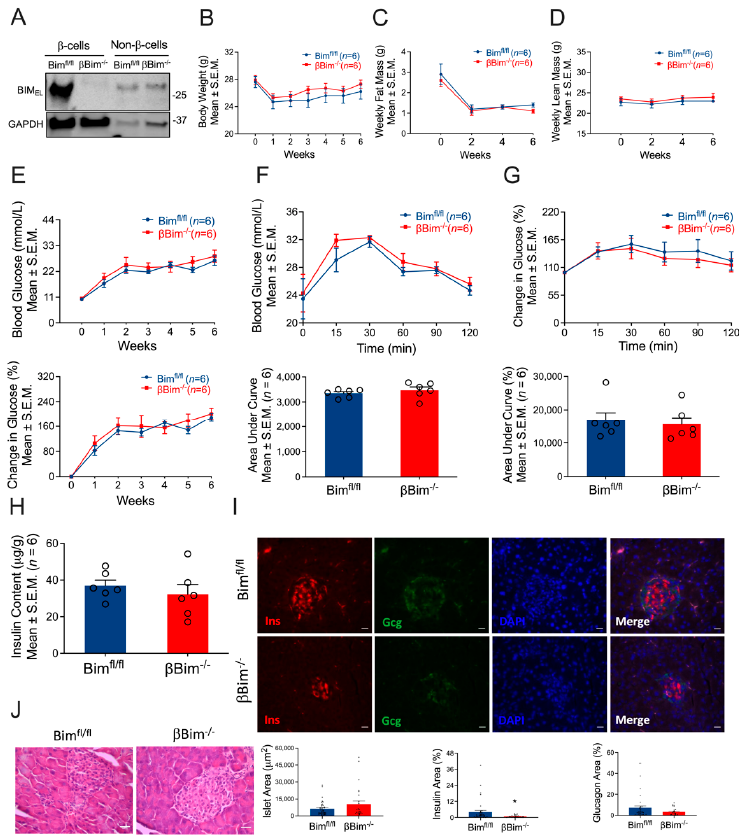
Figure 3. Impact of β -cell-specific Bim deletion on glucose homeostasis. Bim was deleted in β -cells of mice using Cre-LoxP technology. Bim deletion was confirmed in FACS-purified β -cells isolated from islets of Bim fl/fl or β Bim -/- mice by immunoblotting using anti-Bim antibody ( A ). To test the impact of diabetes on glucose homeostasis, Bim fl/fl or β Bim -/- mice were injected with 5-days of MLD- STZ and followed for 6 weeks. Body weight ( B ), body composition ( C , D ), and blood glucose ( E ; top and bottom panel) were monitored following STZ injection. GTT was performed in 6 h fasted mice after 6 weeks of STZ administration. Blood glucose was measured at indicated time points and ex- pressed as mmol/L ( F ) or % change in blood glucose normalized to time 0 ( G ). Figure ( F ) ( bottom panel ) and G ( bottom panel ) represent glucose areas under the curve. Pancreatic insulin content was measured in an acid–ethanol extracted fraction using a commercial ELISA kit ( H ). Destruction and distortion of endocrine cells was observed in STZ-diabetic mice with the presence of dead and inflammatory cells. Pancreatic sections were stained for insulin and glucagon and DNA. Scale bar, 20 µm. Representative of 3 mice per genotype ( I ). Bottom panel ( I ) showing islet area, insulin, and glucagon positive cells (calculated as % of total islet area). Histology of mouse pancreas stained by Hematoxylin and Eosin ( J ). Scale bar, 25 µm. Data are presented as Mean ± SEM. * p < 0.05 vs. Bim fl/fl mice.